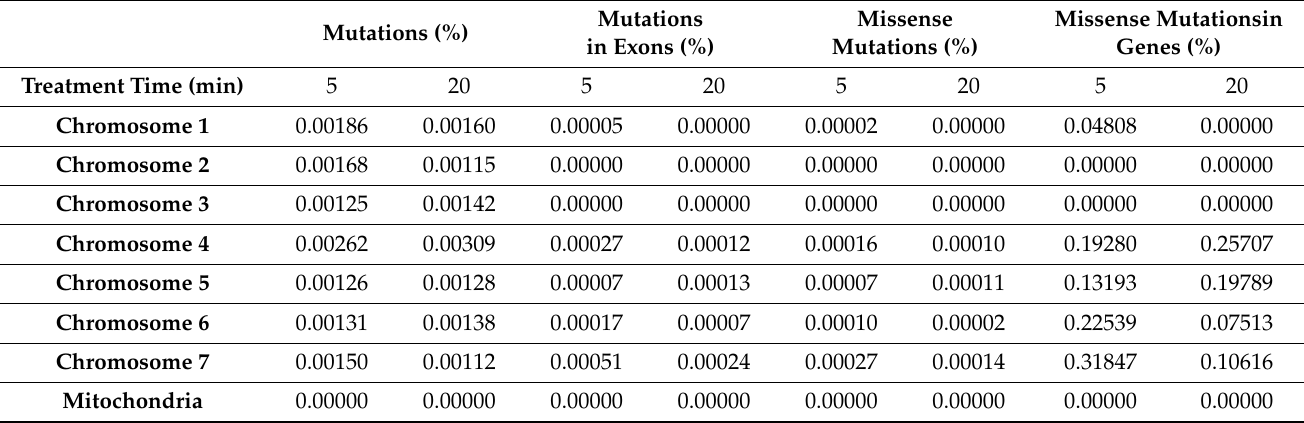
Table 3. The percentage of mutations in each chromosome and mitochondrial genome of A. oryzae after treatment with plasma for 5 min and 20